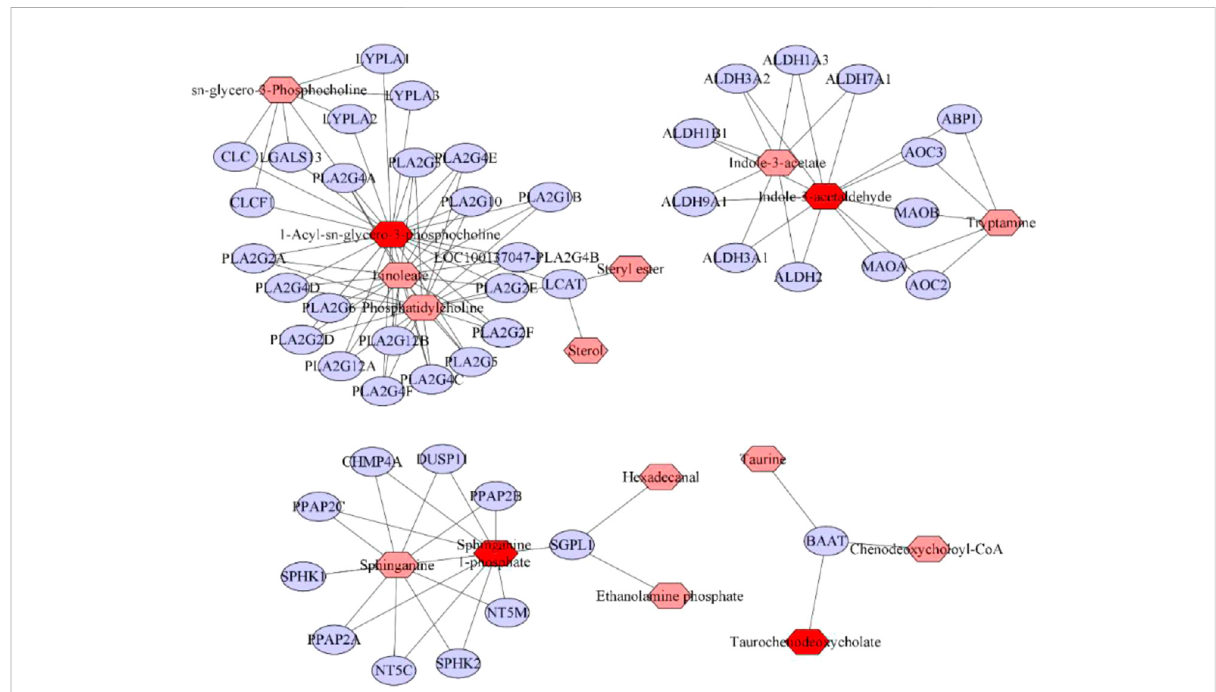
FIGURE 8 Metabolite-Gene network of GYP on LLC mice. Red, pink and blue nodes respectively represent differential metabolites of GYP recovery, interacting metabolites and metabolite related gene.